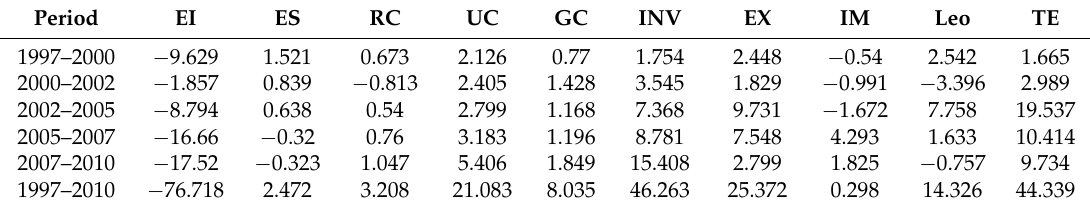
Table 5. Decomposition factors of changes in CO 2 emissions in China (10 9 ton CO 2